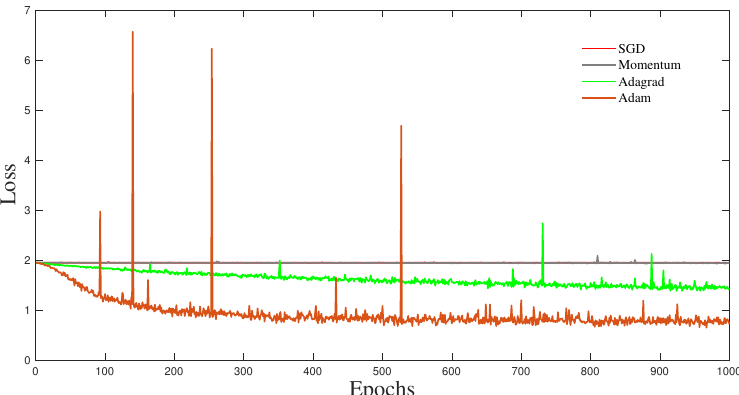
Figure 6. The performance of the Adam optimizer in the loss